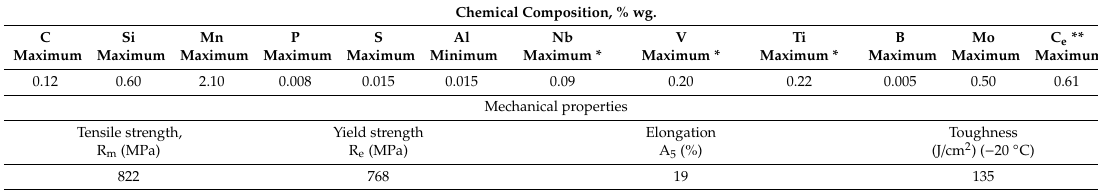
Chemical composition according to PN EN 10149-2 and mechanical properties of thermo-mechanically rolled S700MC steel.